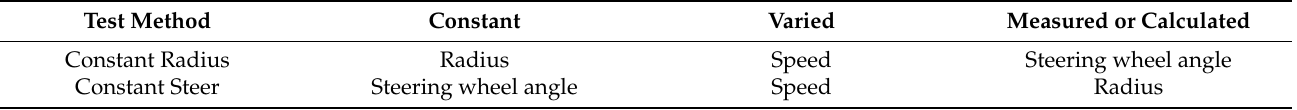
Table 1. ISO 4138—test